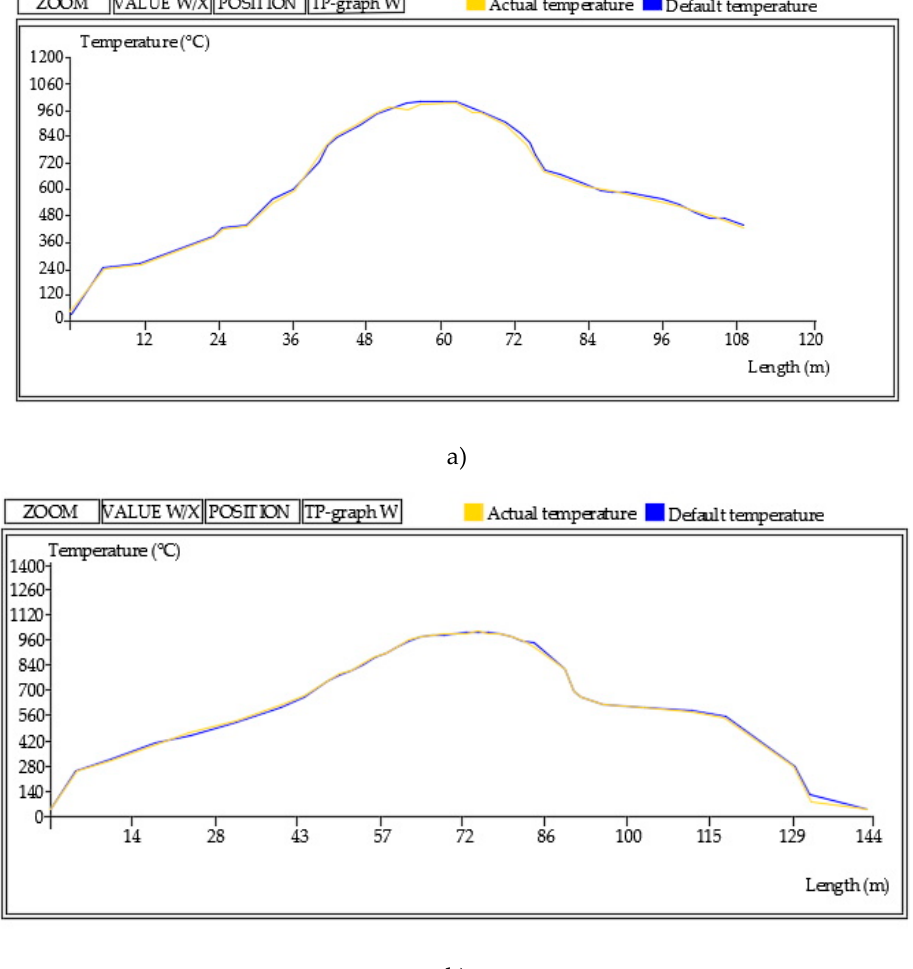
Figure 4. Firing regime of the bricks ( a ) at 1030 °C and ( b ) at 1060 °C.